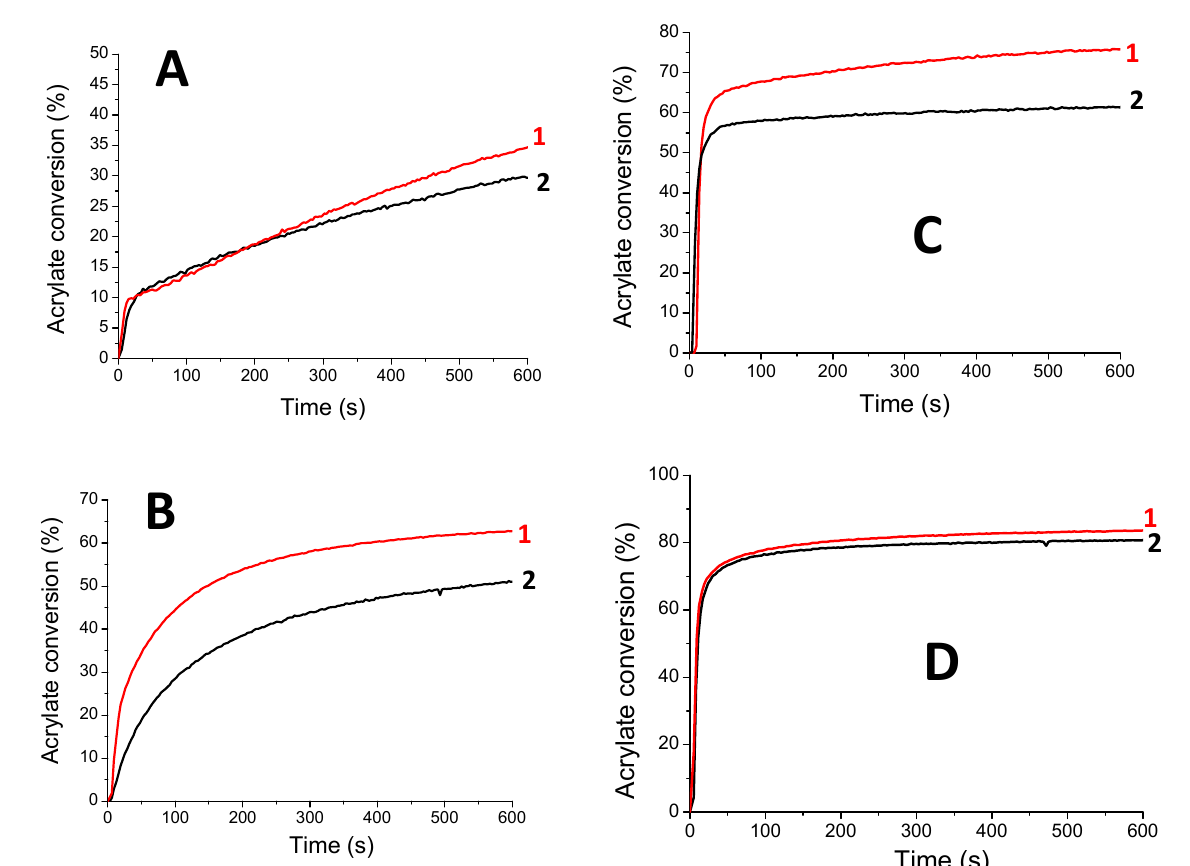
13 of 20 Figure 3. The normalized experimental (1) and simulated (2) EPR spectra obtained upon in situ LED@400 nm exposure of 2-substituted naphthoquinone derivatives in acetonitrile under argon in the presence of DMPO spin trap: ( A ) HNQ/Iod, ( B ) HNQA /Iod, ( C ) HNQE /Iod, ( D ) HNQ/Iod/TT, ( E ) HNQA /Iod/TT, and ( F ) HNQE /Iod/TT. Irradiation time: 450 s ( A – C ) and 225 s ( D – F ). Modulation amplitude of 0.025 mT. Free-radical polymerization of SOA. HNQ, HNQA, and HNQE have been first used as a one-component photoinitiating system without the addition of any co-initiators (Fig- ure 4A,B). The free-radical polymerizations of SOA were followed in laminate by RT-FTIR under LEDs@405 nm and 385 nm irradiation. The final acrylate conversions of SOA are displayed in Table 5. Interestingly, HNQA and HNQE alone can initiate the FRP of SOA with interesting acrylate conversions. These results confirm the previous EPR results and highlight the capability of the resulting carbon-centered radicals (Figure 2E,F) to initiate FRP of acrylate monomer. This is particularly interesting in terms of the green chemistry approach as only one component photoinitiating system is used, reducing the carbon at- oms consumption. Not surprisingly, when HNQA (or HNQE ) is combined with Iod, the